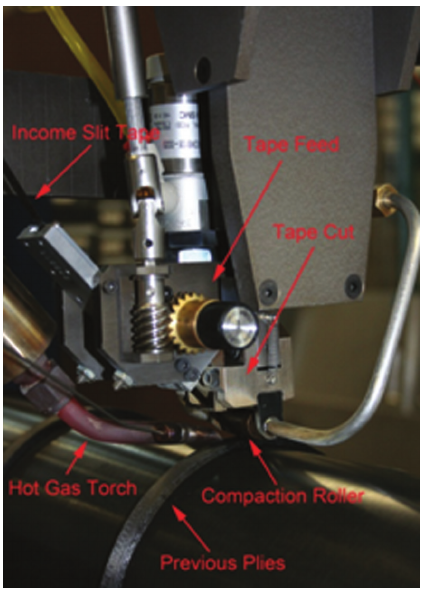
Figure 1: Automated fiber placement head (courtesy of National Research Council